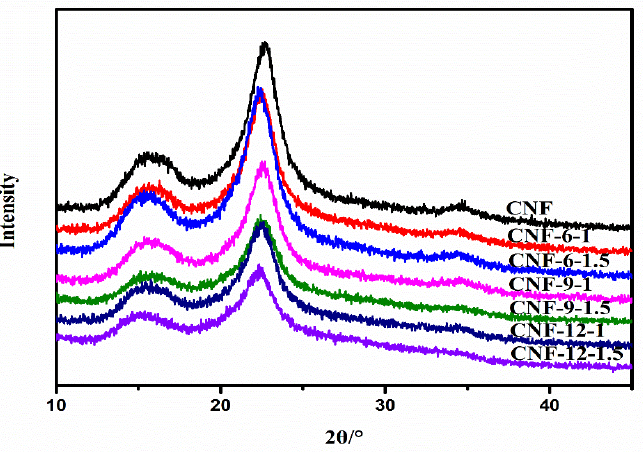
Figure 6. X-ray diffraction curves of original fibers and DES-treated pulp after nano-fibrillation.